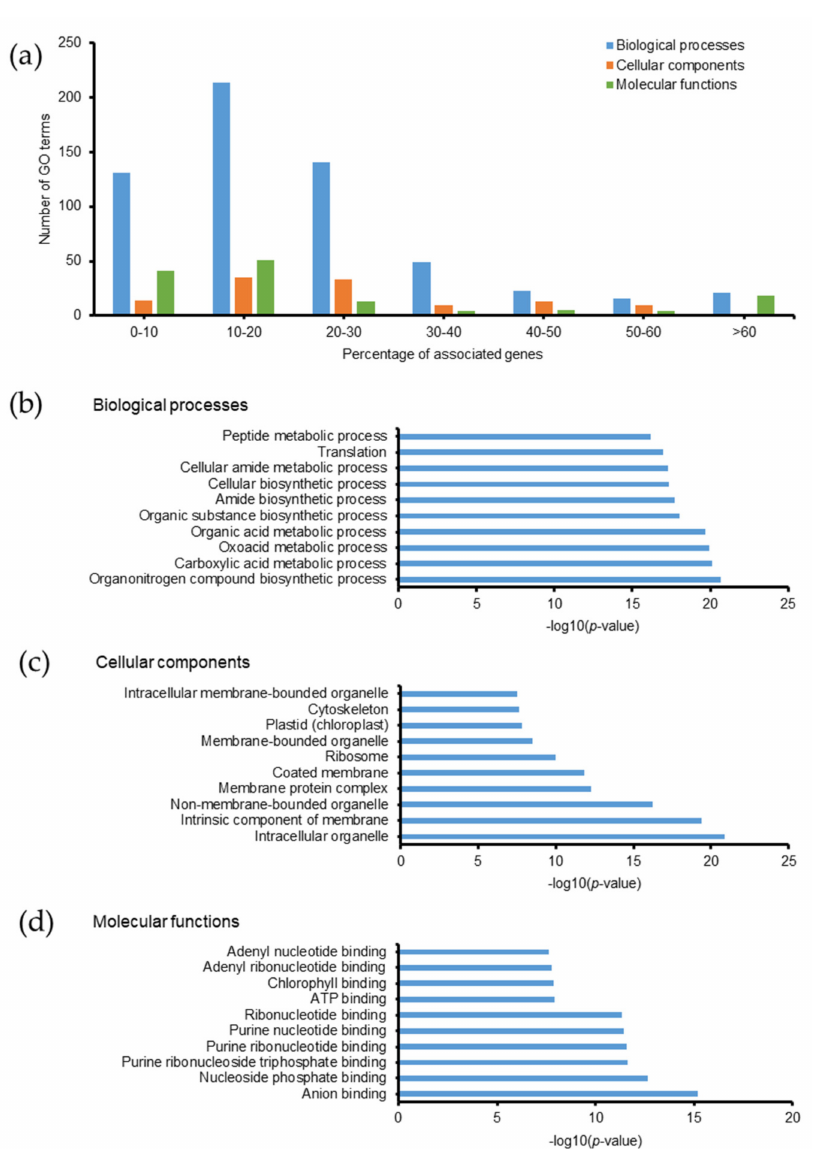
Figure 5. Gene ontology of methylated proteins in Emiliania huxleyi using ClueGO. ( a ) Summary of the number of GO terms according to percentage associated genes. Top 10 ( b ) biological processes, ( c ) cellular components, and ( d ) molecular functions based on − log( p